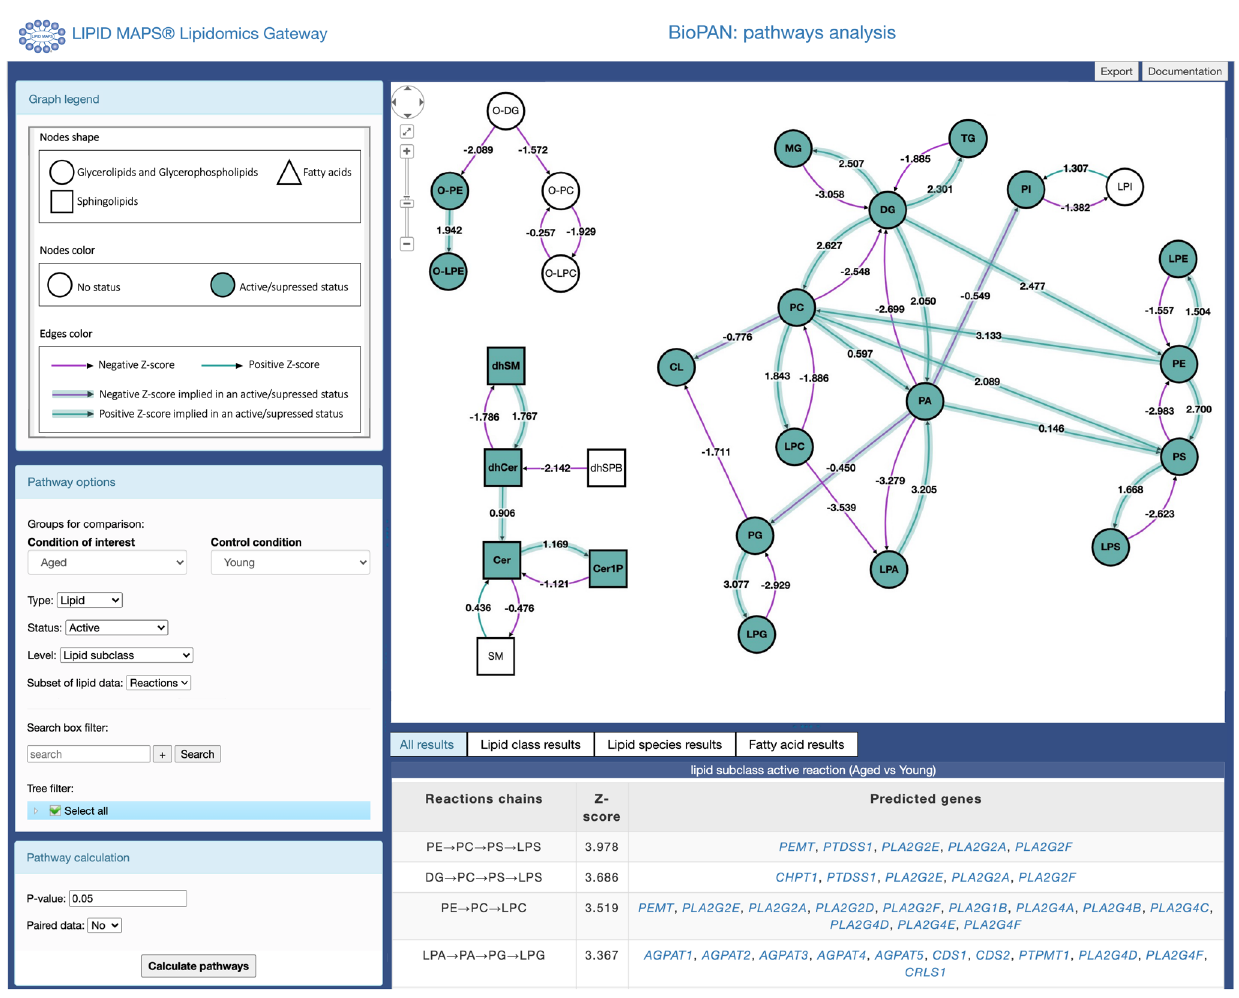
Figure 1. Main results page view for BioPAN. Pathways are displayed as an interactive graph at the centre of the screen. Users have control over the information presented in the graph using the menus on the left side panel and results tables are displayed at the bottom of the